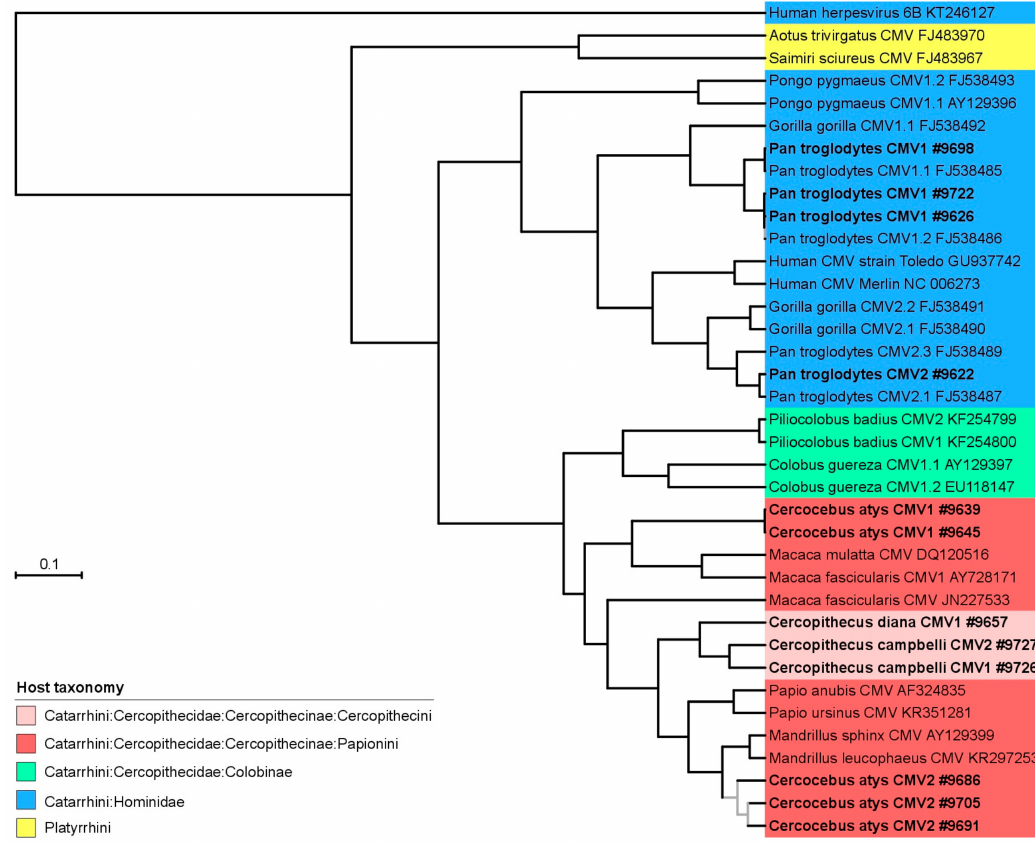
Figure 4. Bayesian Markov chain Monte Carlo tree of partial CMV UL55 amino acid sequences. Sequences generated for this study are bold and displayed with their sample number (accession numbers in Table 1). Internal branches supported by posterior probabilities <0.95 are grey. The common names of the hosts after which the viruses are named are given in the legend of Figure